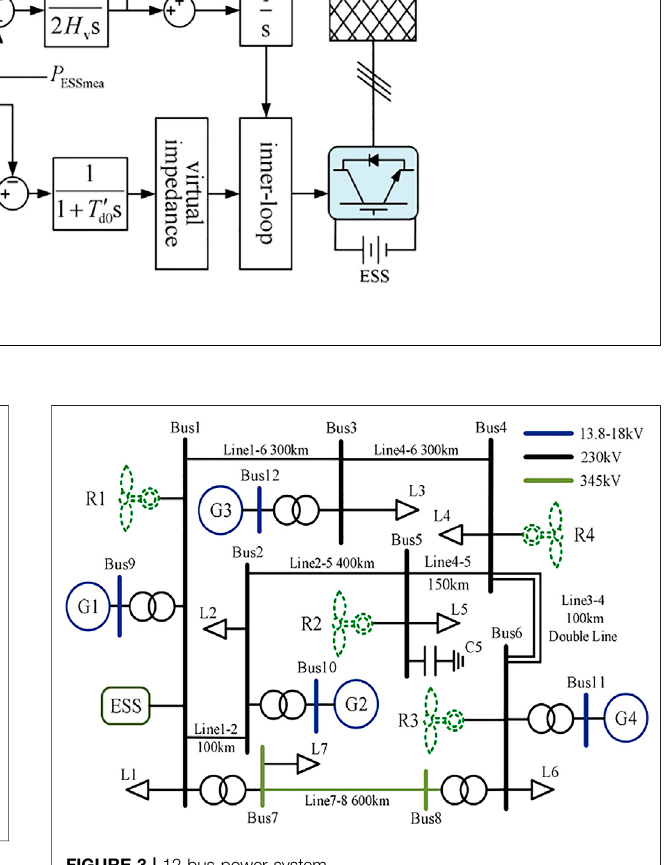
FIGURE 3 | 12 bus power